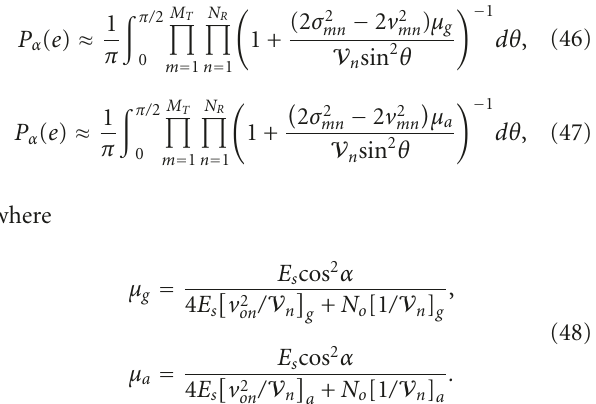
denote, respectively, the geometric and arithmetic means of all ( v 2 / V n )’s and (1 / V n )’s. Following the same steps on